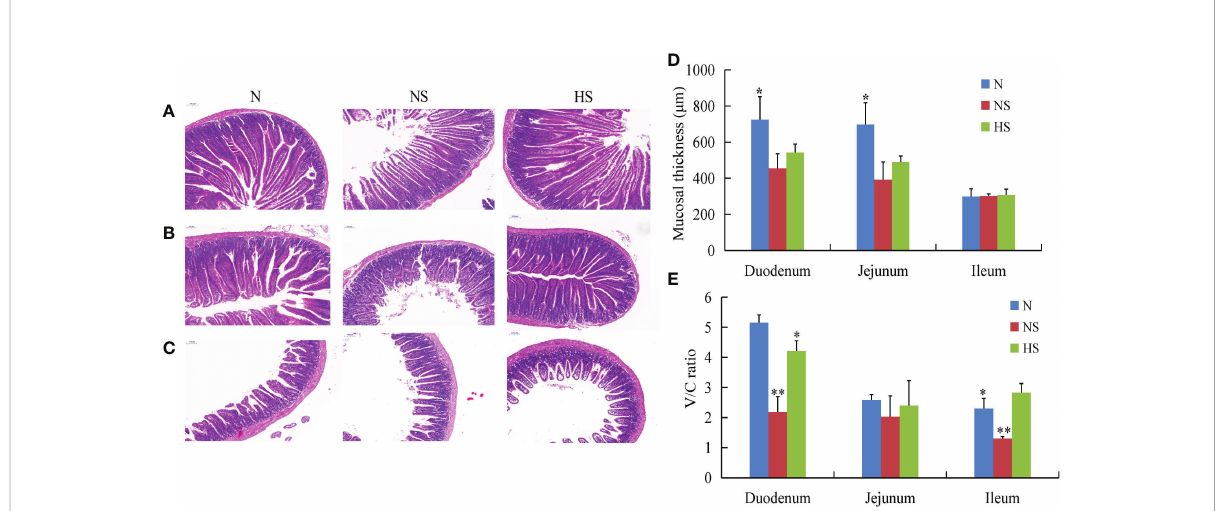
FIGURE 4 Effect of Terminalia bellirica (Gaertn.) Roxb. on intestinal physical barrier function in Salmonella Typhimurium -infected mice. (A – C) Histological examination of the duodenum, jejunum, and ileum stained with H&E on a 100- m m scale bar. (D) Mucosal thickness of intestinal segments. (E) Ratio of small intestinal villus height to crypt depth. The results were evaluated through one-way ANOVA. All the data represent means ± SD. Unmarked data indicate no signi fi cant difference ( P > 0.05); * P < 0.05; ** P < 0.01.